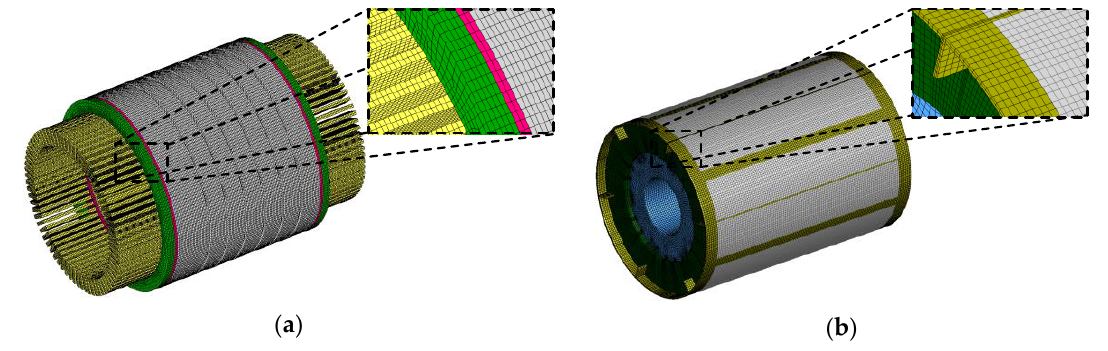
Figure 4. The solving domain mesh generation of HVLSSR-PMSM: ( a ) Stator mesh generation; ( b ) Rotor mesh generation.